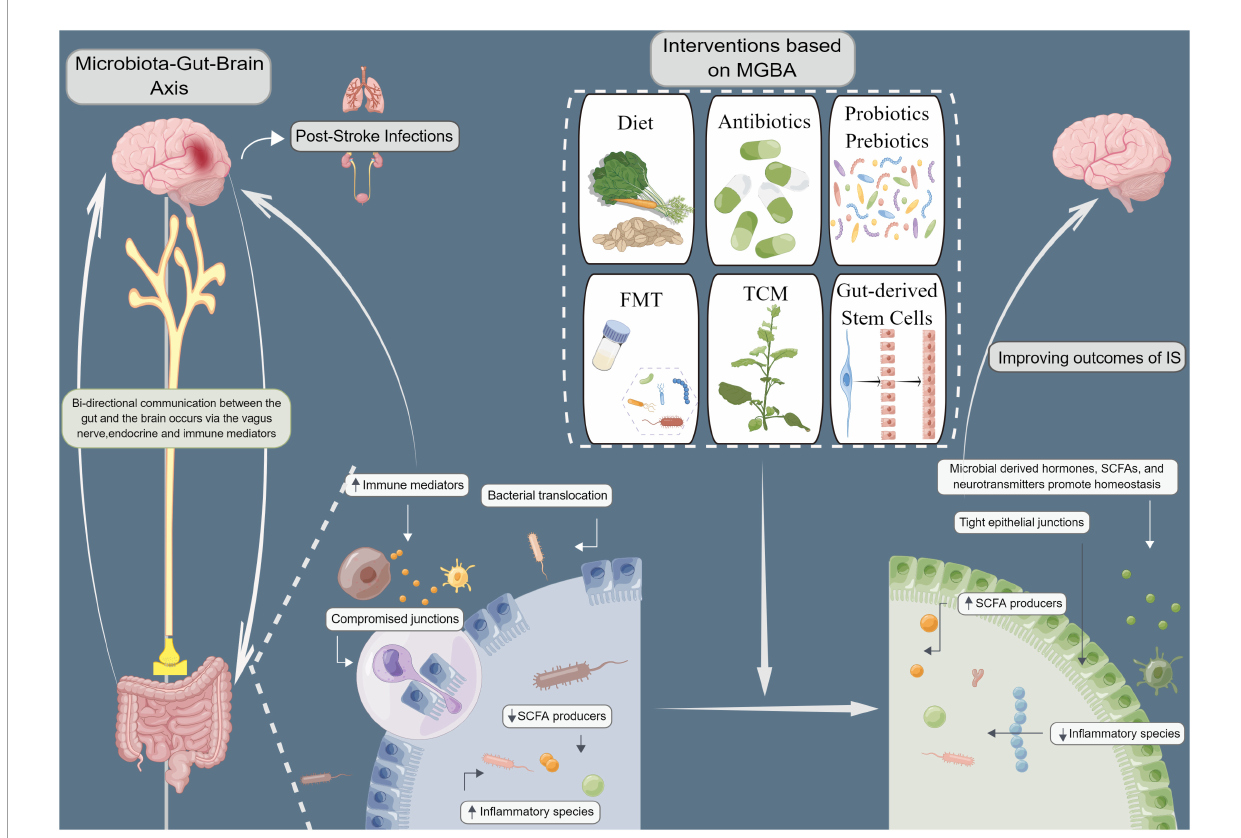
FIGURE1 Improving ischemic stroke outcomes (IS) with microbiota-gut-brain axis (MGBA)-based interventions. Microbiological interventions, including dietary interventions, antibiotics, probiotics and prebiotics, fecal microbiota transplantation (FMT), traditional Chinese medicine (TCM), and intestinal stem cell transplantation can improve MGBA by altering microbial communities. The gut microbiome is known to be highly involved in the biosynthesis and release of various hormones, neurotransmitters, and numerous active metabolites and agents that may directly or indirectly regulate MGBA via neurobiological networks, immunological processes, and/or microbial metabolic signaling pathways, thereby affecting brain function and systemic inflammation. Modulation of gut microbiota composition and microbiota-derived metabolites may prevent infectious complications and improve neurological outcomes in IS patients by increasing short-chain fatty acids (SCFAs) and neurochemicals, decreasing gut permeability, reducing bacterial translocation, and alleviating